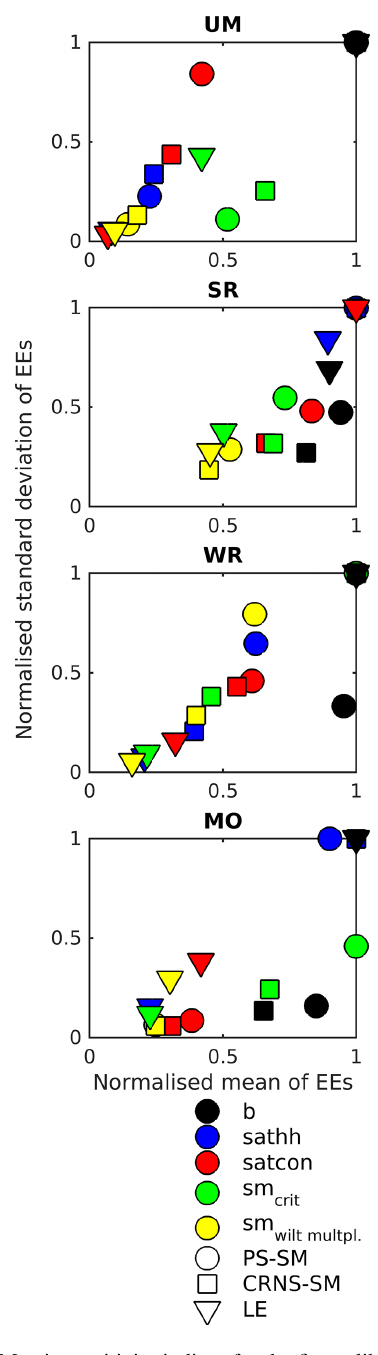
Figure B1. Morris sensitivity indices for the five calibrated param- eters at four sites: UM, SR, WR, and MO. The three objective func- tions are the RMSEs between simulated and observed PS soil mois- ture (PS-SM), CRNS neutron counts (CRNS-N), and latent heat flux (LE). The mean elementary effects (EEs), representing the main ef- fects, are displayed along the horizontal axis. The standard devia- tions of the elementary effects, representing parameter interactions, are shown along the vertical axis. Values were normalized to the most influential parameter for each objective